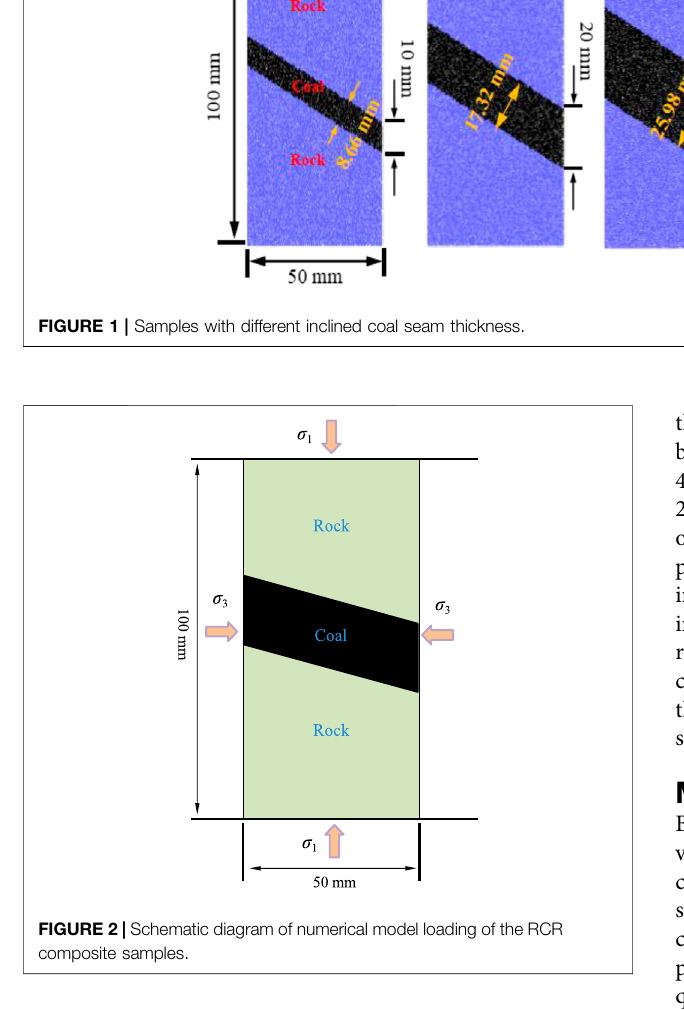
Frontiers in Physics |